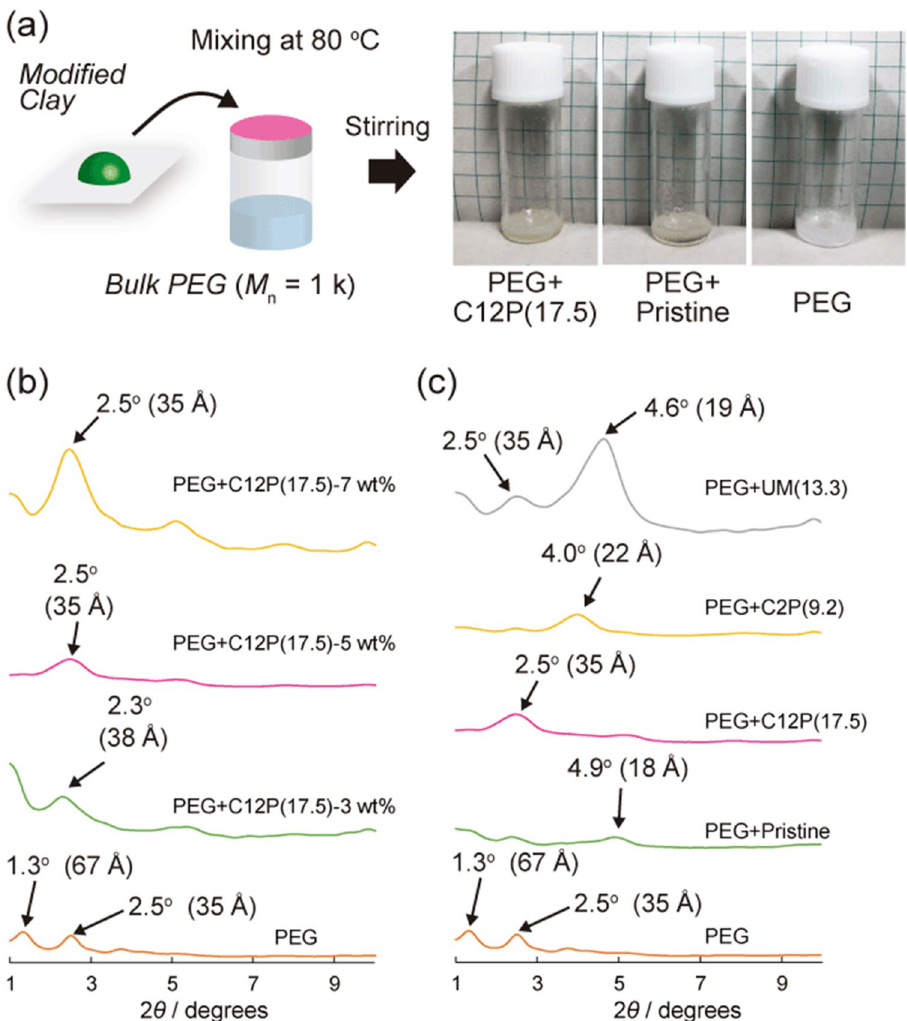
Figure 5. Clay in the PEG matrix. ( a ) Preparing a nanocomposite with modified clay. PXRD patterns of PEG with ( b ) various amounts of added clay and (c) various intercalants.